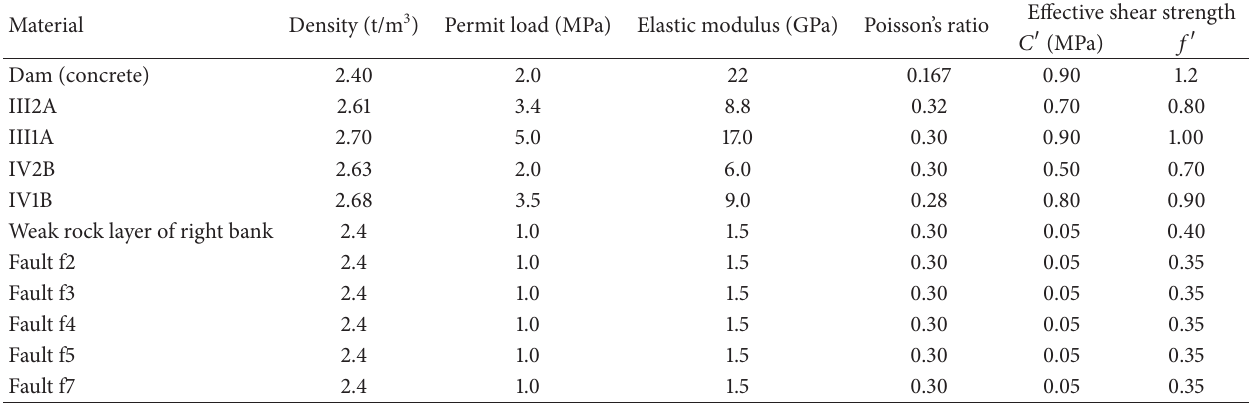
Table 1: Physical-mechanical parameters of the concrete dam, the rock mass, and faults.